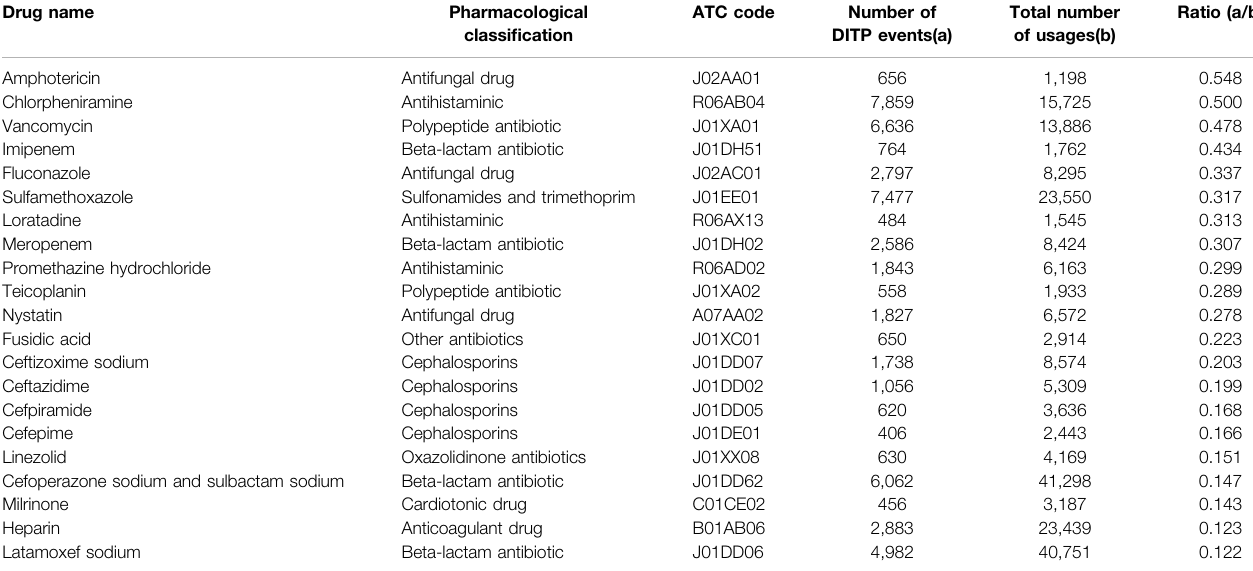
TABLE 1 | Suspected drugs associated with thrombocytopenia in the pediatric population. Drug